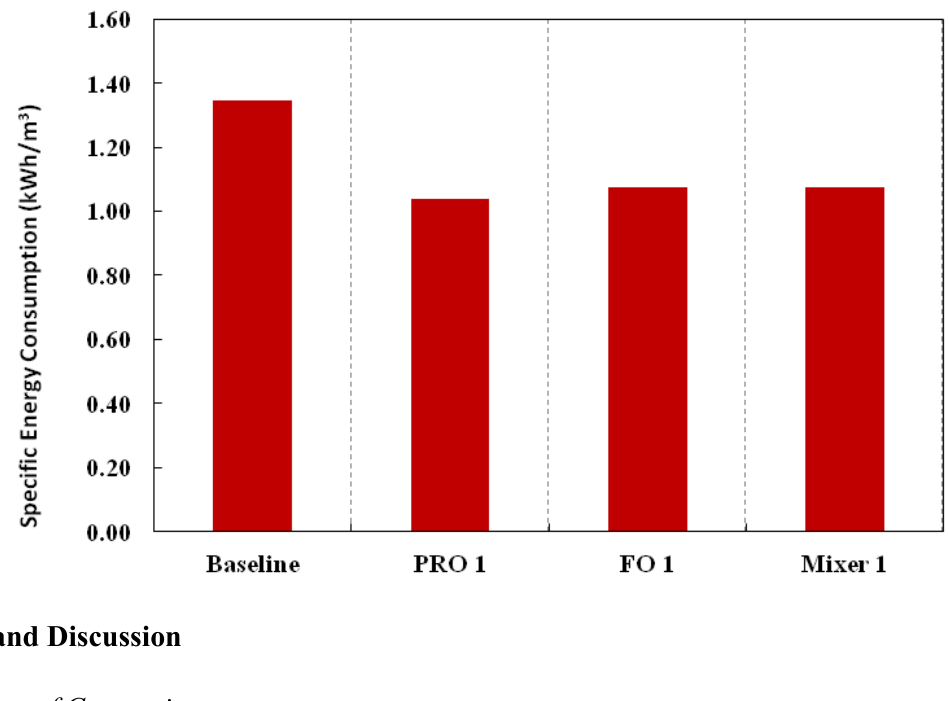
Figure 10. Specific Energy Consumption of the various configurations expressed in the conventional way in terms of unit volume of product